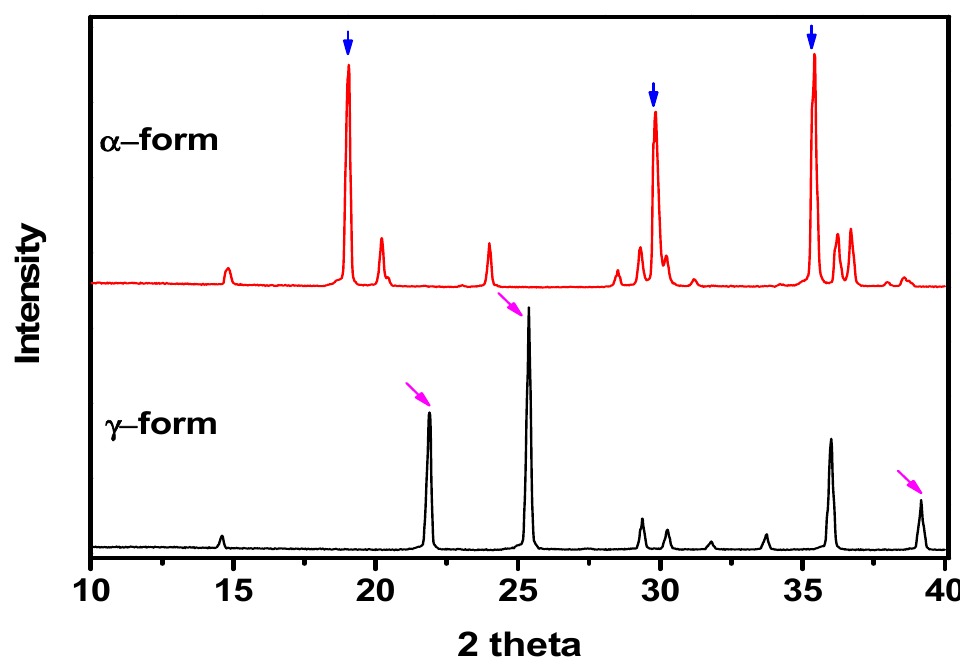
Figure 2. PXRD patterns of the α -form and γ -form glycine crystals. The bule arrows indicate the characteristic peaks of α -form (~19.05 ◦ , ~29.9 ◦ , and ~35.4 ◦ ), and the pink arrows indicate the characteristic peaks of γ -form (~21.8 ◦ , ~25.3 ◦ , and ~39.1 ◦ ). The result for standard calibration of peak area ratio and polymorphic fraction is plotted in Figure 3b. The linear fitting equation with R 2 = 0.9898 was applied to estimate Area ratio = (Area )/(Area + Area ) the polymorphic fraction in crystal samples during phase transformation. Here, the X axis (cid:2869)(cid:2871)(cid:2870)(cid:2873)(cid:2879)(cid:2869)(cid:2871)(cid:2874)(cid:2868) (cid:2913)(cid:2923) (cid:3127)(cid:3117) (cid:2869)(cid:2871)(cid:2870)(cid:2873)(cid:2879)(cid:2869)(cid:2871)(cid:2874)(cid:2868) (cid:2913)(cid:2923) (cid:3127)(cid:3117) (cid:2869)(cid:2872)(cid:2872)(cid:2873)(cid:2879)(cid:2869)(cid:2872)(cid:2874)(cid:2873)(cid:2913)(cid:2923) (cid:3127)(cid:3117) is the mass fraction of γ -form glycine, and the Y axis is the peak area